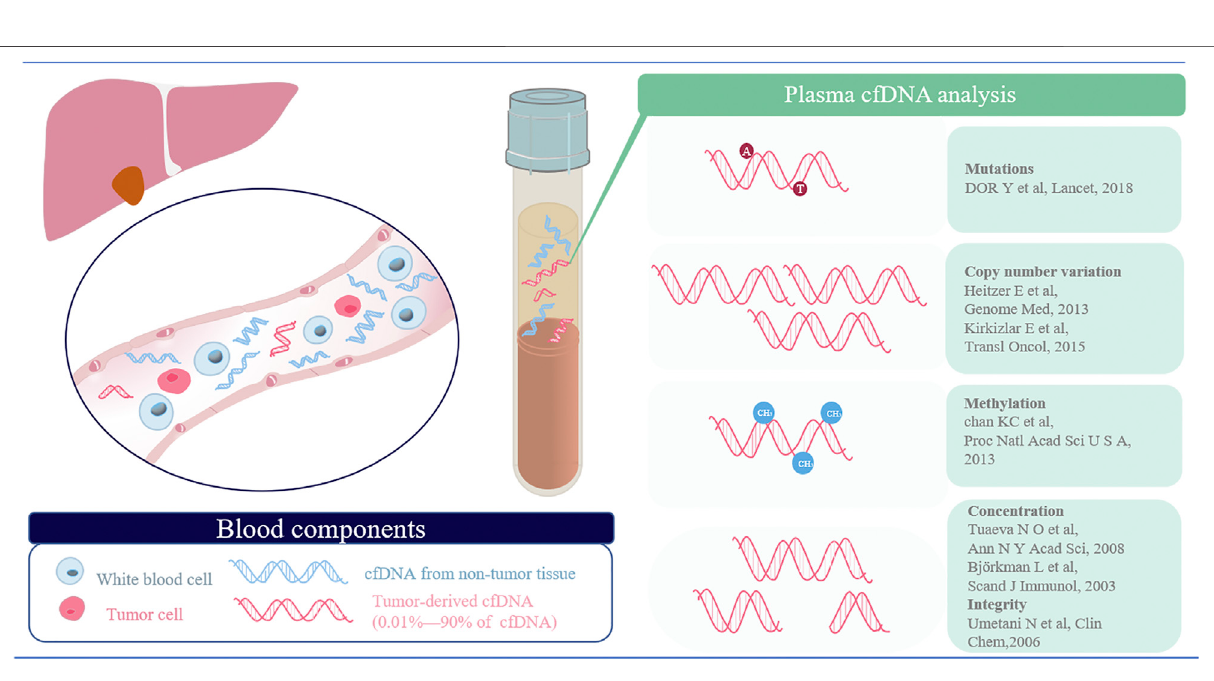
Frontiers in Molecular Biosciences |